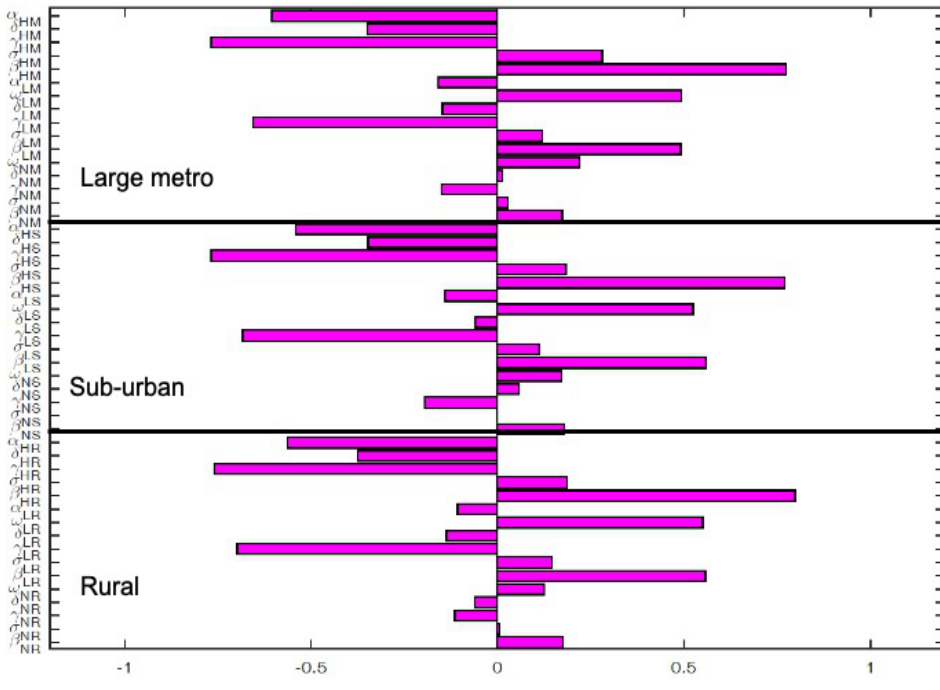
Figure 5. Partial rank correlation coefficient (PRCC) values of the MRSA model using as response function infected individuals when the patches (large metropolitan, suburban, and rural areas) are isolated. Parameter values used are given in Tables